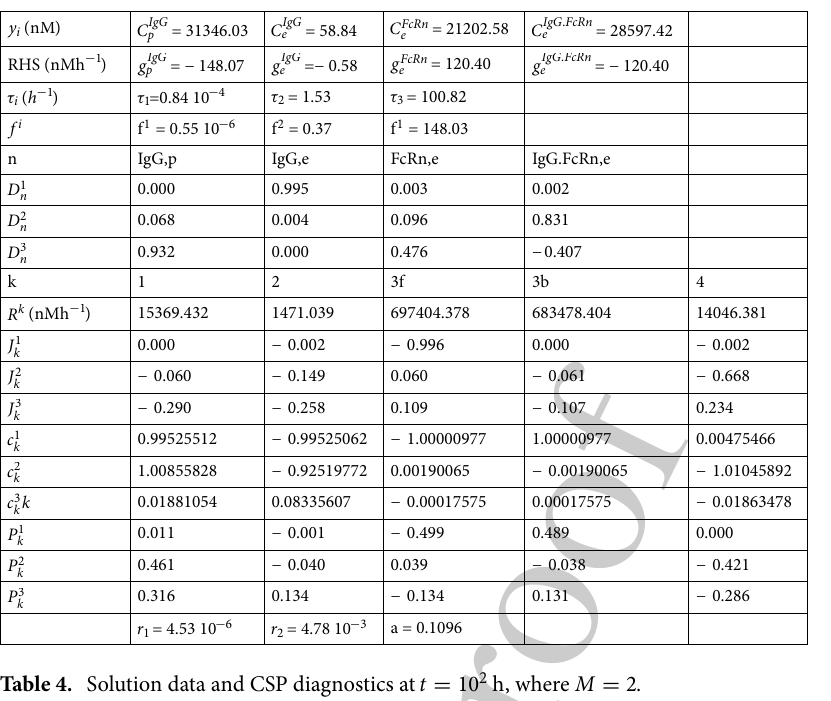
shows that the equilibrium expressed by the relation f 2 ≈ 0 involves mainly the equilibration of R 4 and R 2 with R 1 ( R 4 + R 2 ≈ R 1 ), in which R 2 contributes only at the start of the M = 2 period. Indicative values of all CSP diagnostics for this period are provided in Table 4, as they were computed at t = 10 2 . All these informations lead to the conclusion that in the M = 2 period the QSSA of the C variables are valid. In order to assess the accuracy of these approximations, the relative errors er 1 1 , er 1 2 and er 1 3 in approximating ( R 3 f − R 3 b ) in Eqs. (32–34) were computed along with the relative errors: